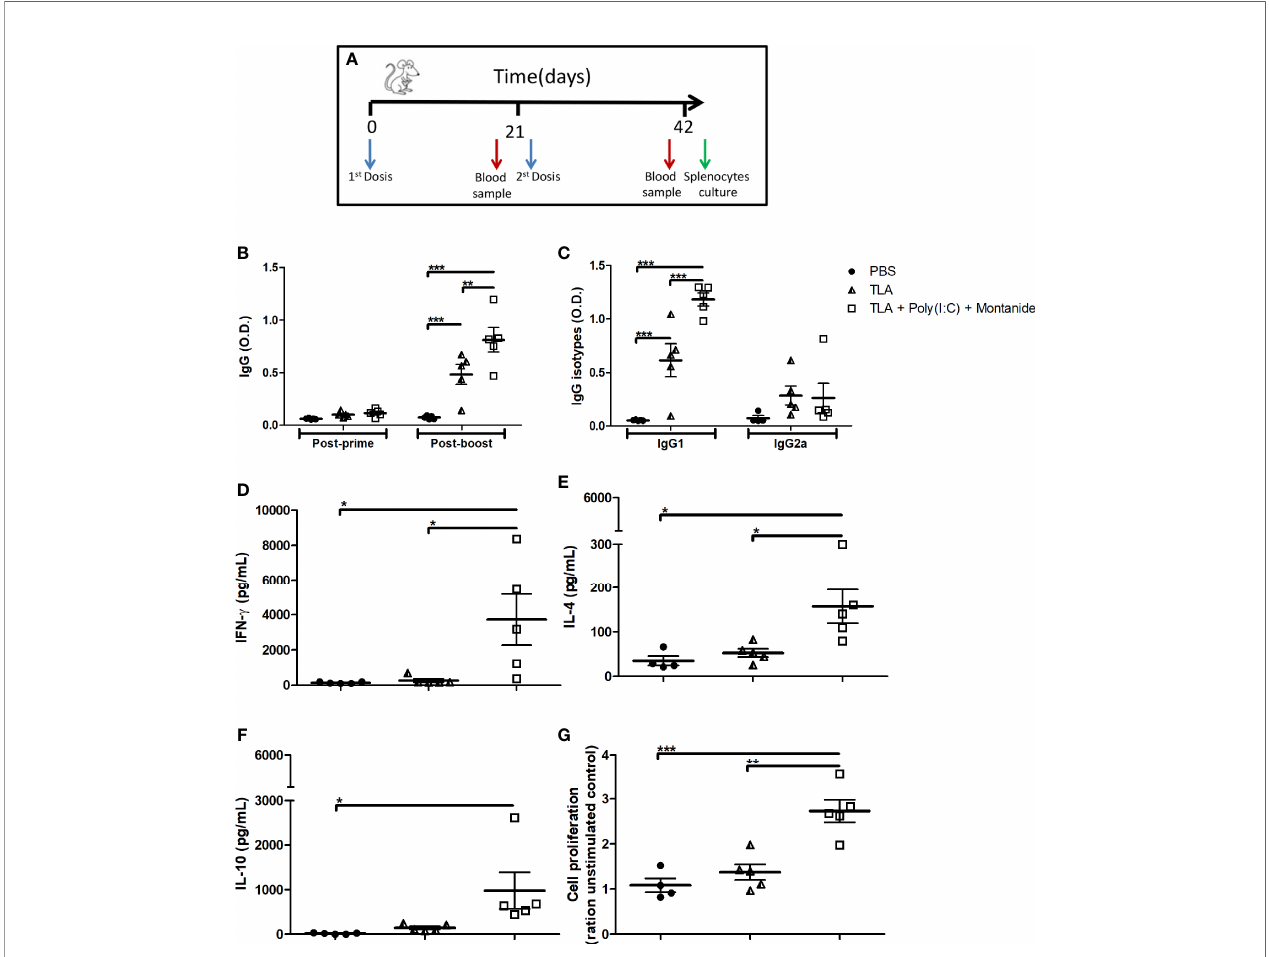
FIGURE 1 | Humoral and cellular immune response in immunized mice. Vaccination scheme (A) . Anti- Leishmania IgG antibodies (B) using serum samples dilution (1:500) obtained 3 weeks after each immunization. Anti- Leishmania IgG1 and IgG2a (C) antibodies using serum samples dilution (1:1,000) obtained 3 weeks after boost. Results are presented as the mean ± standard error of mean (SEM) of optical density (O.D.) values from biological replicates obtained from 5 animals per groups. Cytokine levels of IFN- g (D) , IL-4 (E) , and IL-10 (F) measured by enzyme-linked immunosorbent assay (ELISA) using supernatant of splenocytes stimulated with TLA for 72 h 3 weeks after boost; results are presented as the mean ± SEM of cytokine concentration (pg) from biological replicates obtained from 5 animals per group. Cell proliferation assay (G) determined by MTT on stimulated splenocytes with TLA for 72 h 3 weeks after boost; results are presented as the mean ± SEM of the cell proliferation index (ratio of unstimulated control) from biological replicates obtained from 5 animals per group. Asterisks indicate signi fi cant differences among groups: * p < 0.05; ** p < 0.01; *** p < 0.001 by one-way (C – G) or two-way (A, B) ANOVA and Tukey ’ s or Bonferroni